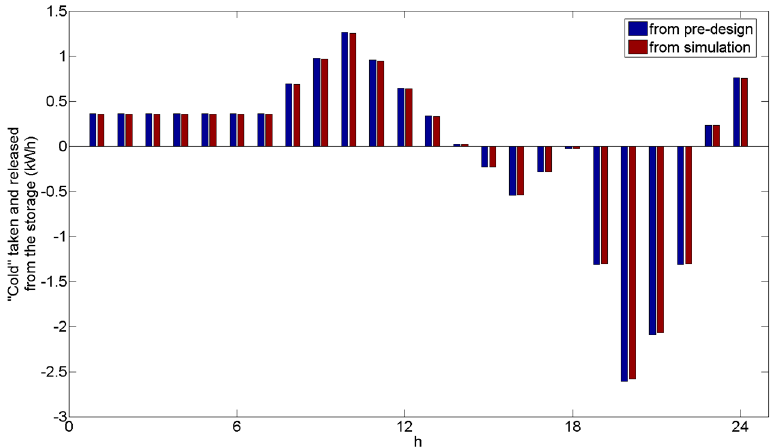
Figure 17. “Cold” taken and released from the PCM tank.